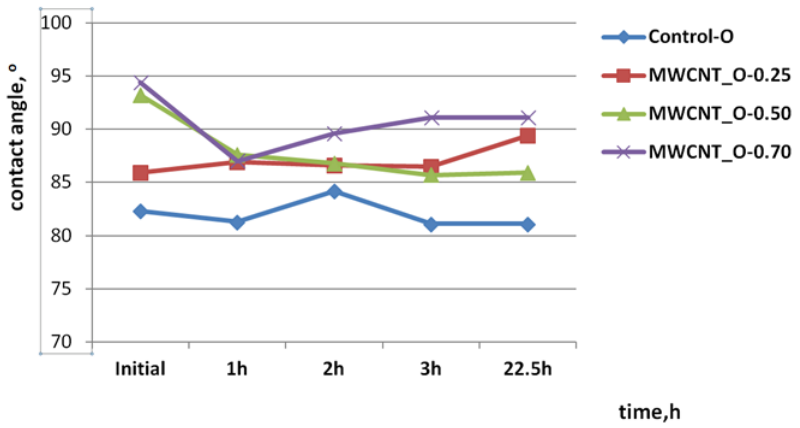
Figure 6. Static and dynamic contact angle of the water drop on the ovine leather surfaces covered with MWCNTs compared with the control sample.